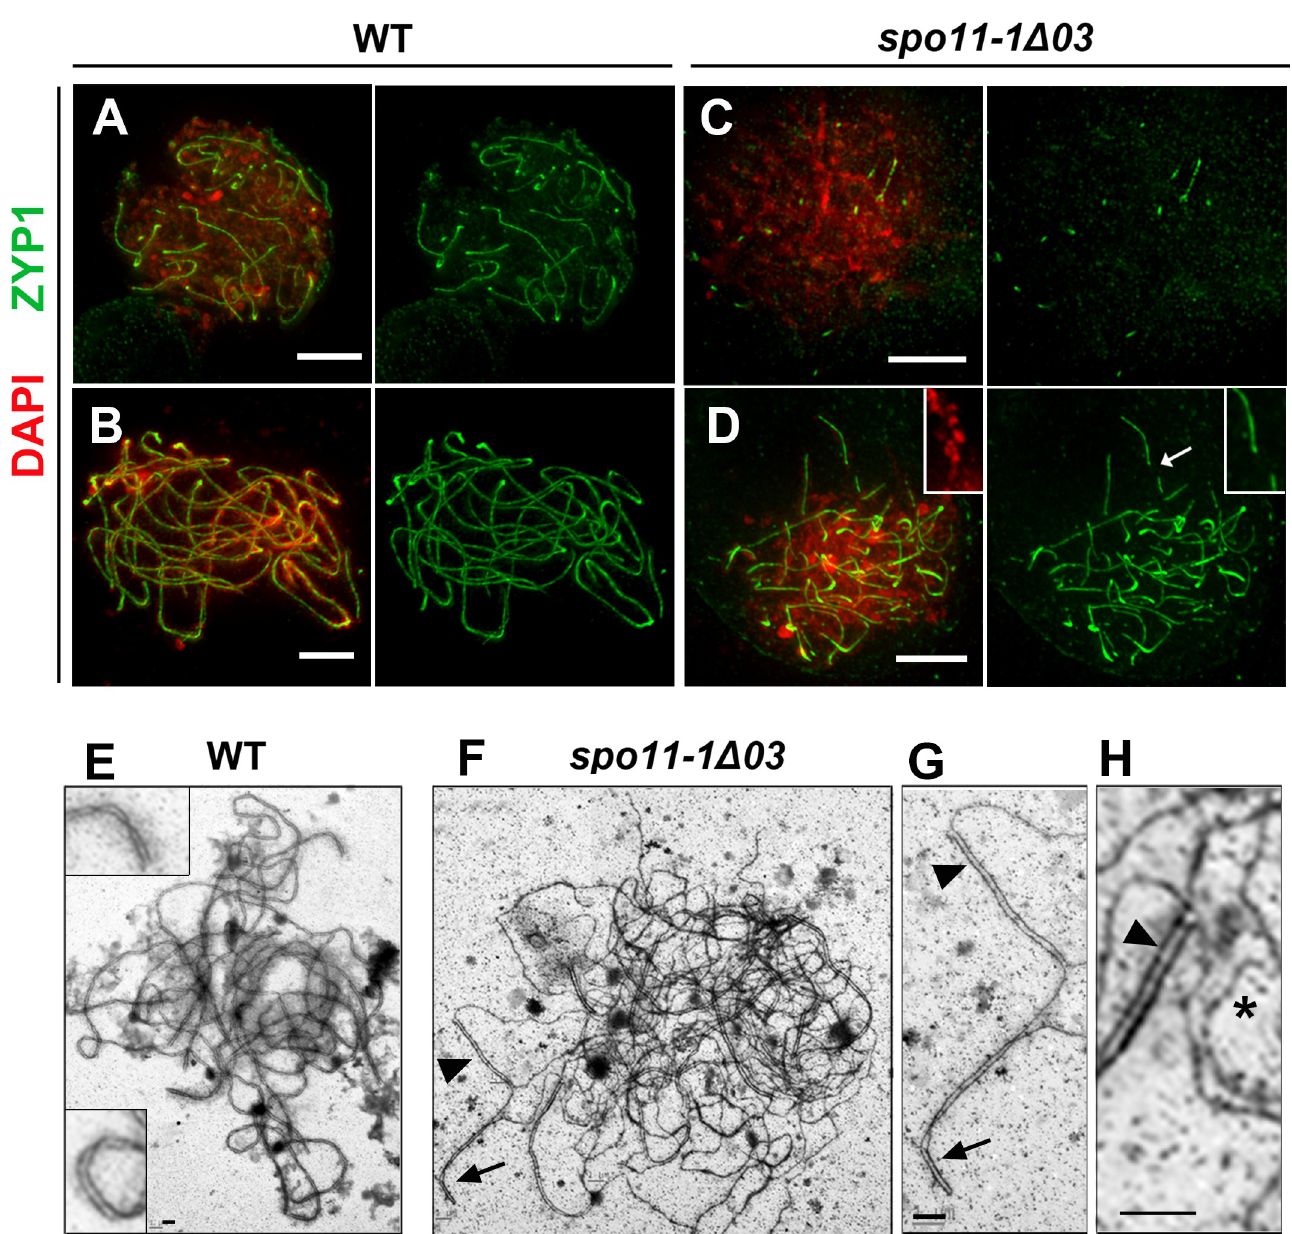
Fig 9. Transverse filament loading is initiated but is not completed. (A-D) Immunostaining of ZYP1 (green) with DAPI staining (red) in WT (A, B) and spo11-1- Δ 03 (C, D) meiocytes at zygotene (A, C) and pachytene stages (B, D). Note the magnified region from the pachytene-like mutant meiocyte (D) showing discontinuous ZYP1 stretches (arrow). Scale bars represent 5 μ m. (E-H) Transmission electron microscopy of synaptonemal complex spreads of WT (E) and spo11-1- Δ 03 (F-H) meiocytes. Unlike the complete synapsis in WT, mutants exhibit abnormal synapsis (G and H). Note that synapsis occurs within one axis, forming “fold-back” structures (arrow), and promiscuous synapsis can also be seen as unequal synapsis with an overhang (arrowheads). In addition, unsynapsed AEs in mutants appear as curly and twisted structures (asterisk in H). Scale bars represent 1 μ m. chromosome axes, a localized structural transition may be triggered in the chromosome axes such as by remodeling axial proteins [66], by phosphorylation of ASY1/HOP1 and REC114/ PHS1 via the ATM-mediated DNA damage response [15, 67], or simply by AE condensation, to prepare the sites for sequential interhomolog recombination or to prevent additional DSB